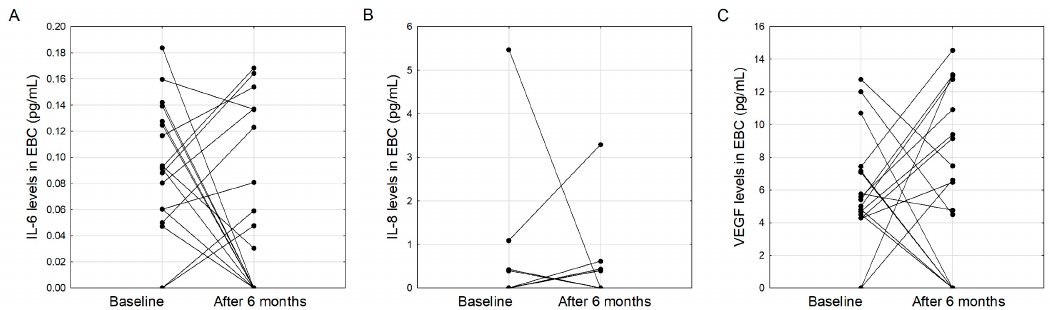
Figure 3. Cytokine concentrations in EBC during the six months of assessment: IL-6 ( A ), IL-8 ( B ), VEGF-A ( C